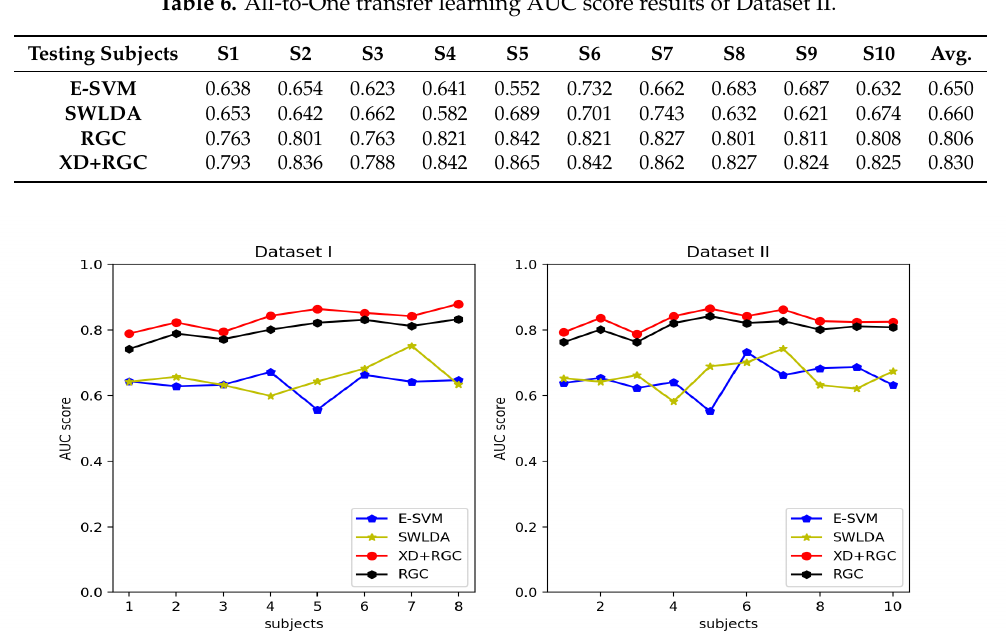
Figure 7. All-to-One transfer learning result of: Dataset I ( left ); and Dataset II ( right